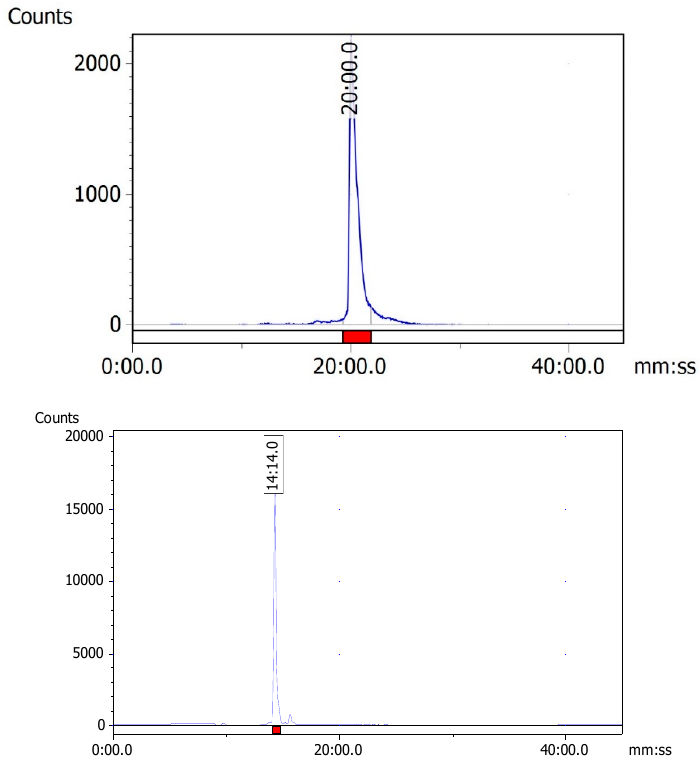
Figure 4. Radio-HPLC chromatograms of 99m Tc-HER2 (above) and 99m Tc-MUC1 (below).